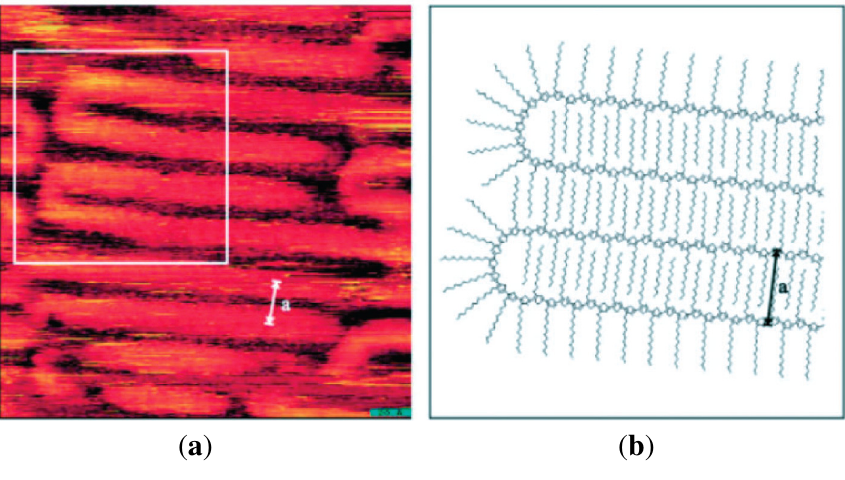
Figure 3. ( a ) Scanning tunneling microscope image of chain folding for regioregular poly(3-dodecylthiophene); ( b ) Calculated model of chain folding (Reprinted with permission from reference [64]. Copyright 2002 Wiley-VCH Verlag GmbH &